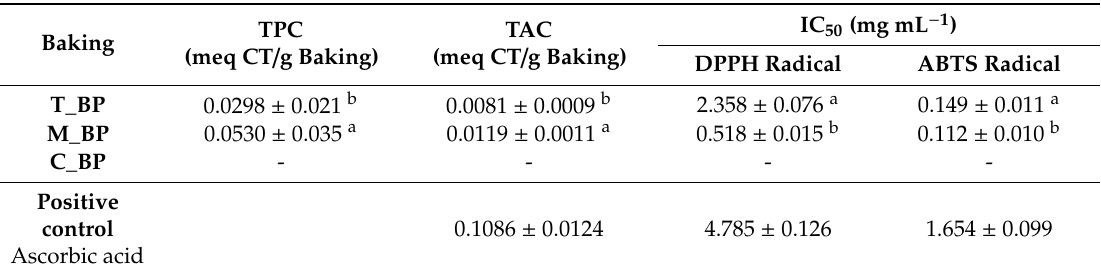
Table 2. Antioxidant performances of baking powders. Data are presented asmean ± SD ( n = 3), di ff erent letters in the same columns are statistically di ff erent ( p < 0.05).